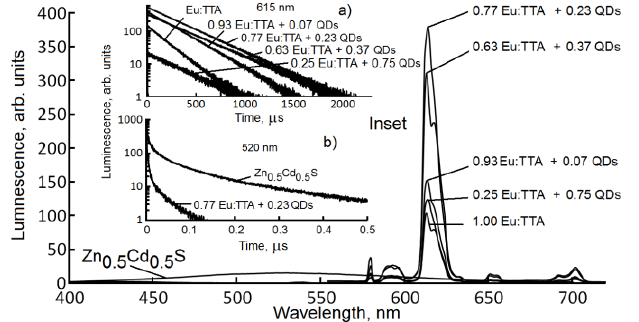
Fig. 1. Spectra of luminescence of Zn 0.5 Cd 0.5 S/TGA+Eu 3+ :TTA. In the insert is decay of luminescence of Zn 0.5 Cd 0.5 S/TGA and Eu 3+ :TTA.